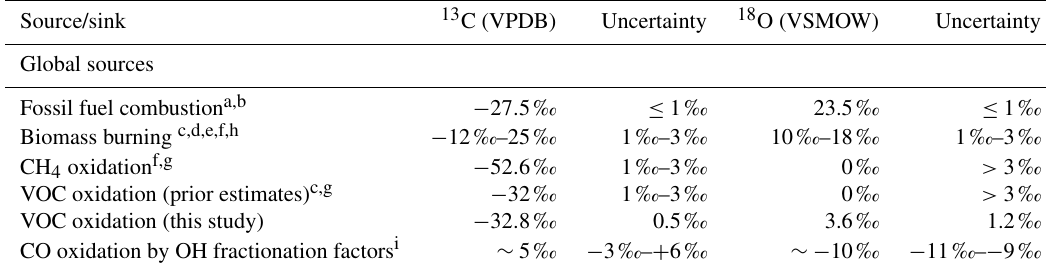
Table 1. The four main CO sources and the OH sink listed with their isotopic signatures and uncertainties.